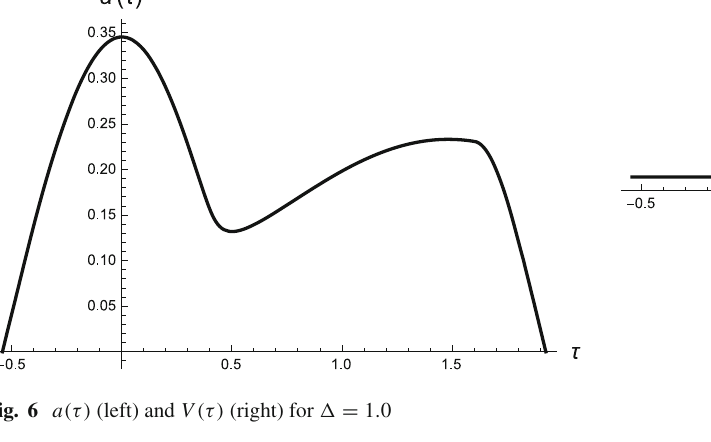
Fig. 6 a (τ) (left) and V (τ) (right) for (cid:19) = 1 . 0